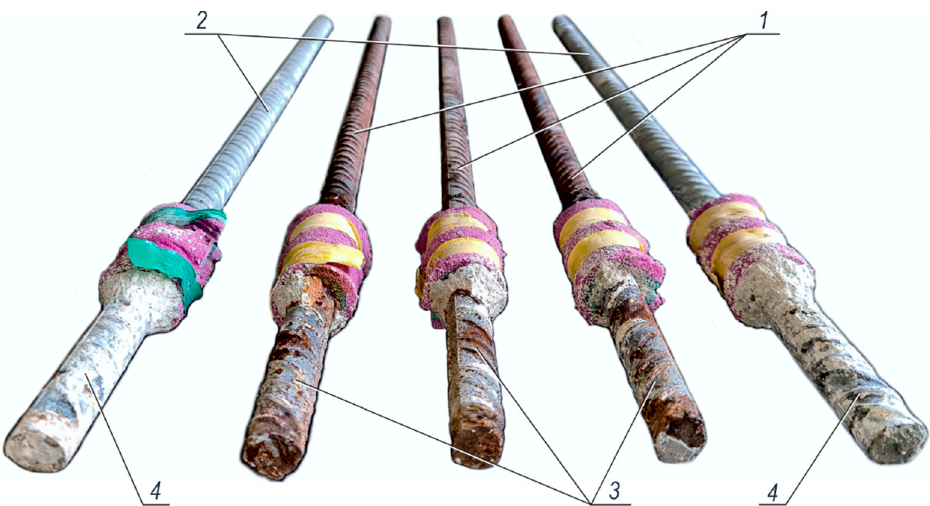
Figure 15. View of ribbed rebars ϕ 16 mm made of steel grade B500SP pulled out from concrete after 540 days: 1 —black steel rebars, 2 —galvanized rebars, 3 —severely corroded fragments of black steel rebars in the area of their embedment in concrete, 4 —fragments of galvanized rebars embedded in concrete.